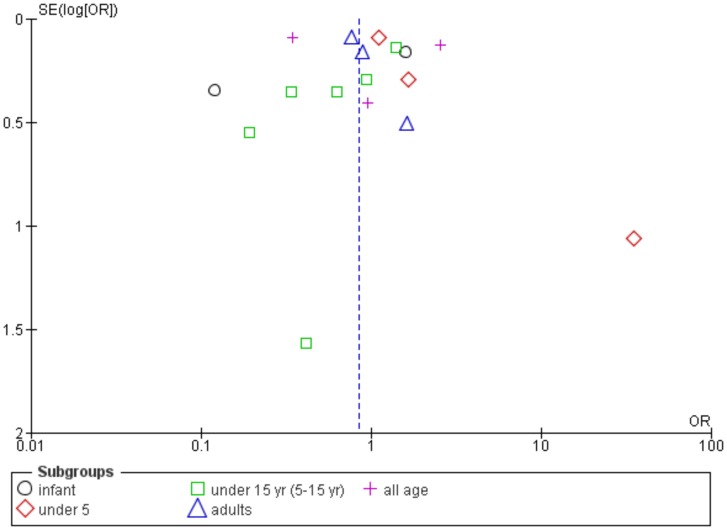
Funnel plot showing publication bias among studies on severe malaria.